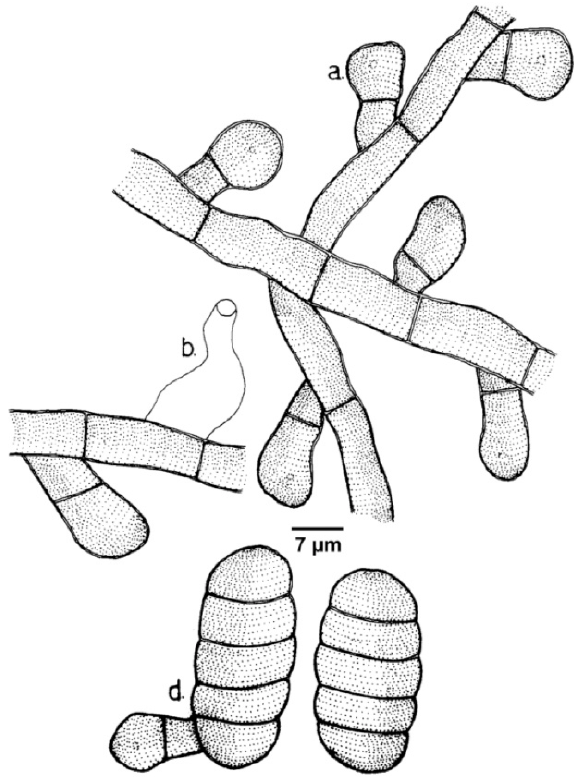
Figure 6. Amazonia vaccinii a - Appressorium; b - Phialide; d -